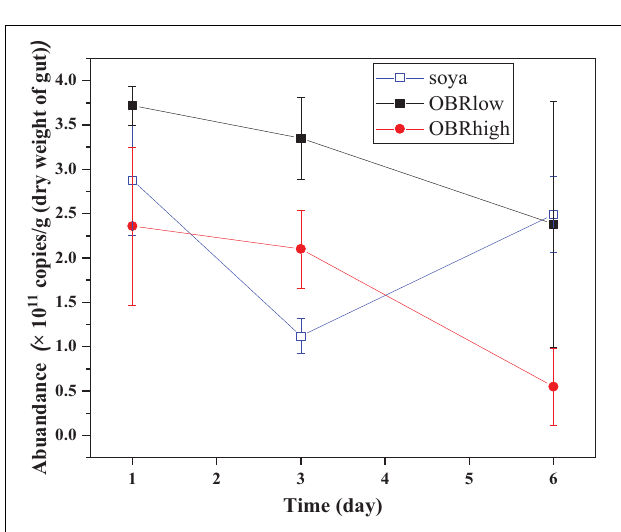
FIGURE 2 | Real-time quantification of the 16S rRNA of the total bacteria in the gut of the larvae (mean ± SE). The soya, OBRlow, and OBRhigh treatments contained only soybean meal, a low amount of OBR, and a high amount of OBR, respectively, 1, 3, and 6 represent the first, third, and sixth day,